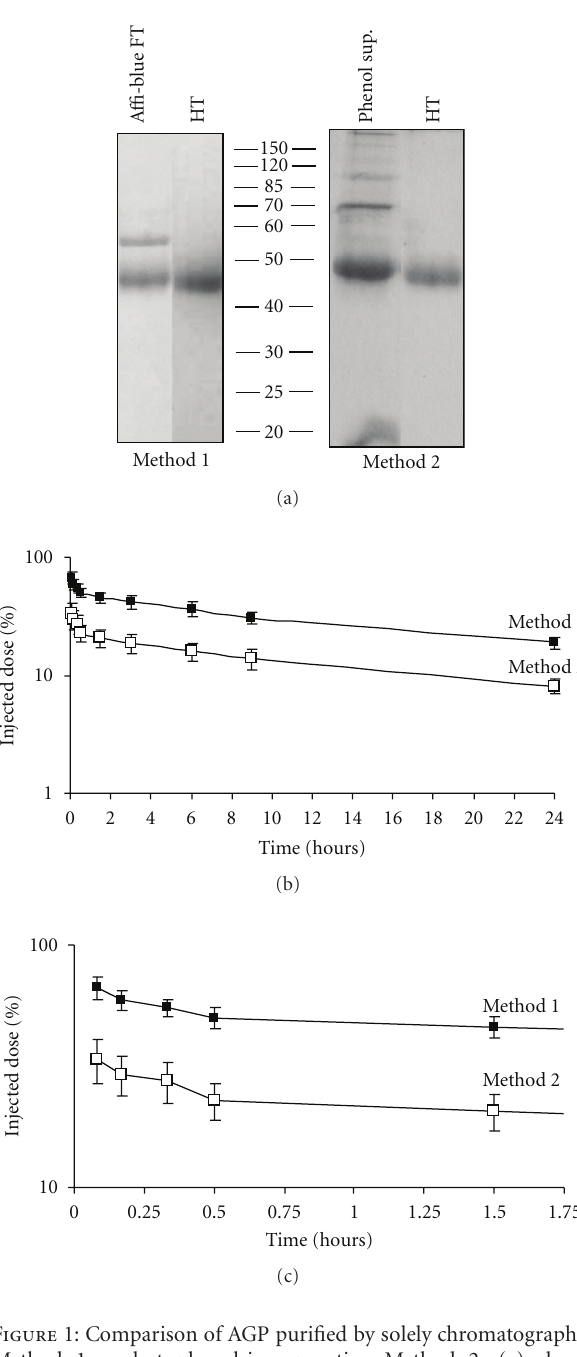
Figure 1: Comparison of AGP purified by solely chromatographic Method 1 or hot phenol-incorporating Method 2. (a) shows Coomassie-stained SDS reducing gels of equivalent (5 μ g total protein/lane) samples of AGP preparations after initial (Cibacron Blue dye column flow-through, A ffi -Blue FT, or hot phenol aqueous phase, Phenol sup.) or secondary hydroxyapatite chromatogra- phy (HT), with the Method number given beneath, and the position of molecular mass markers indicated between (in kDa) the gel images. (b) shows the percentage of the injected dose remaining in mice following injection of radioiodinated AGP purified by either Method 1 or Method 2 ( n = 6, mean ± SD) versus time. (c) is identical to (b), except that the first hour post-injection is expanded to allow visualization of initial time